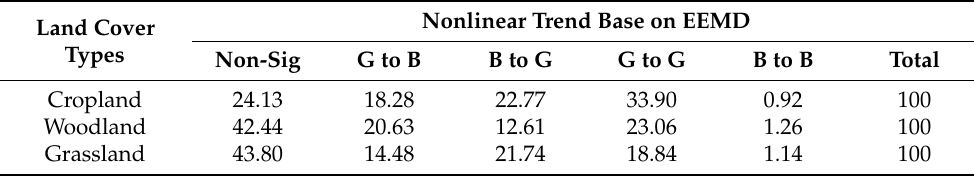
Table 4. The trend of vegetation GSN in different land cover types for EEMD (%). Land Cover Types